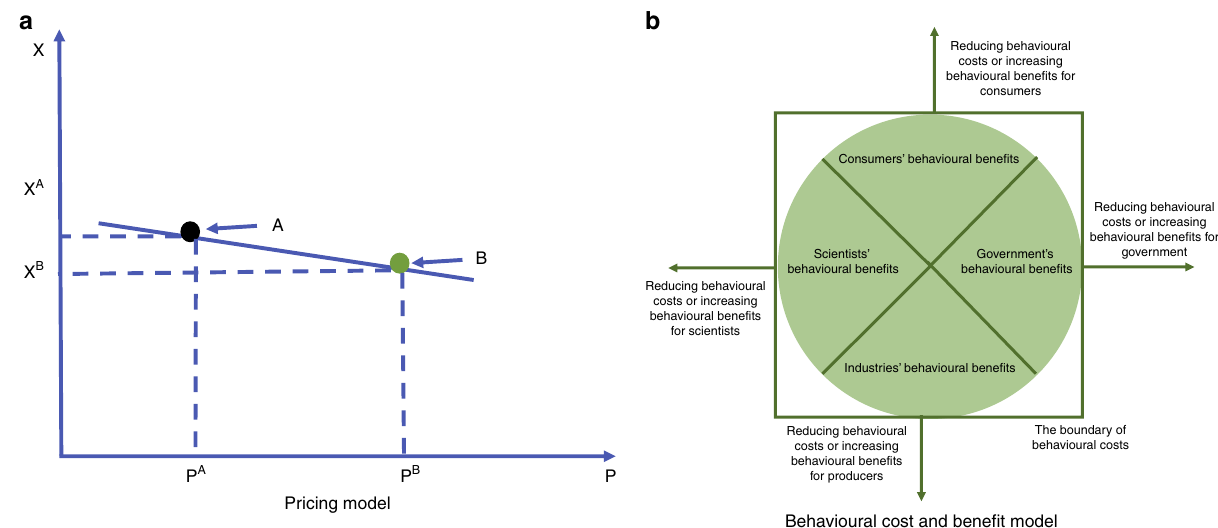
Fig. 1 The graph on the left a shows the pricing model in neoclassical economic theory where the quantity demanded of a normal good (X) has a negative relationship with its price (P). If X ’ s price increases from P A to P B , the quantity demanded of X will decrease from X A to X B . The diagram on the right b shows how behavioural costs and bene fi ts may affect demand. The green area in the circle indicates the behavioural bene fi ts of reducing plastic pollution for consumers, government, industries, and scientists, respectively. The square represents the constraints of behavioural costs. The arrows outside of the square indicate that actions (to mitigate plastic pollution) can be motivated either by increasing behavioural bene fi ts or by decreasing the behavioural costs of the